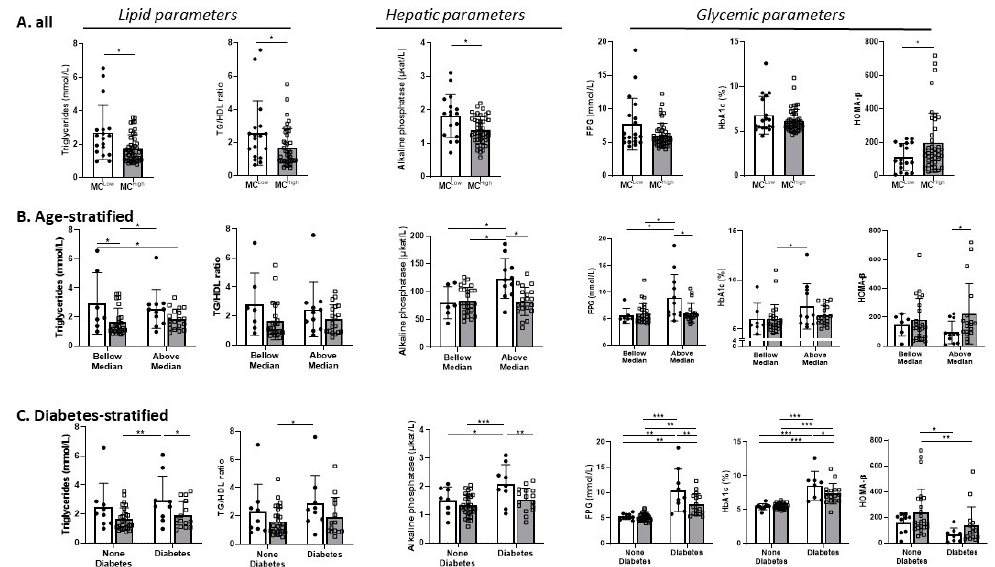
Figure 2. Comparison of clinical parameters between participants with high versus low MC accumulation in VAT. MC low (white bars) were defined as people in whom the expression of both TPSB2 and CMA1 were below the median value of the cohort for each of the genes; all others were defined as MC high (i.e., with either one or two of the genes expressed above median, gray bars). ( A ) Differences in triglycerides (TG)/HDL ratio, alkaline phosphatase, FPG, Hemoglobin A1c (HbA1c), and HOMA- β between VAT- MC low versus VAT- MC high . ( B , C ) Same analysis as in A , but the cohort was stratified by age (below/above median = 45 years, B), or type 2 diabetes status ( C ). Age-adjusted 2 by 2 ANOVA was used to test for variance. Age-adjusted Least Significant Difference (LSD) post- hoc test was used to compare between groups. Values are expressed as mean ± SD. * p < 0.05, ** p < 0.01, *** p < 0.001.